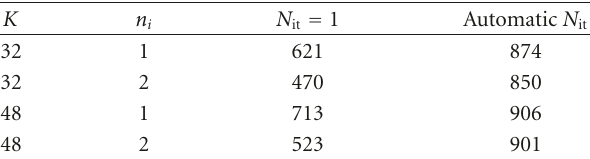
Table 6: Performance of the NHD for N = 8, μ = 1, and ν = 0 . 5 in nonhomogeneous clutter.